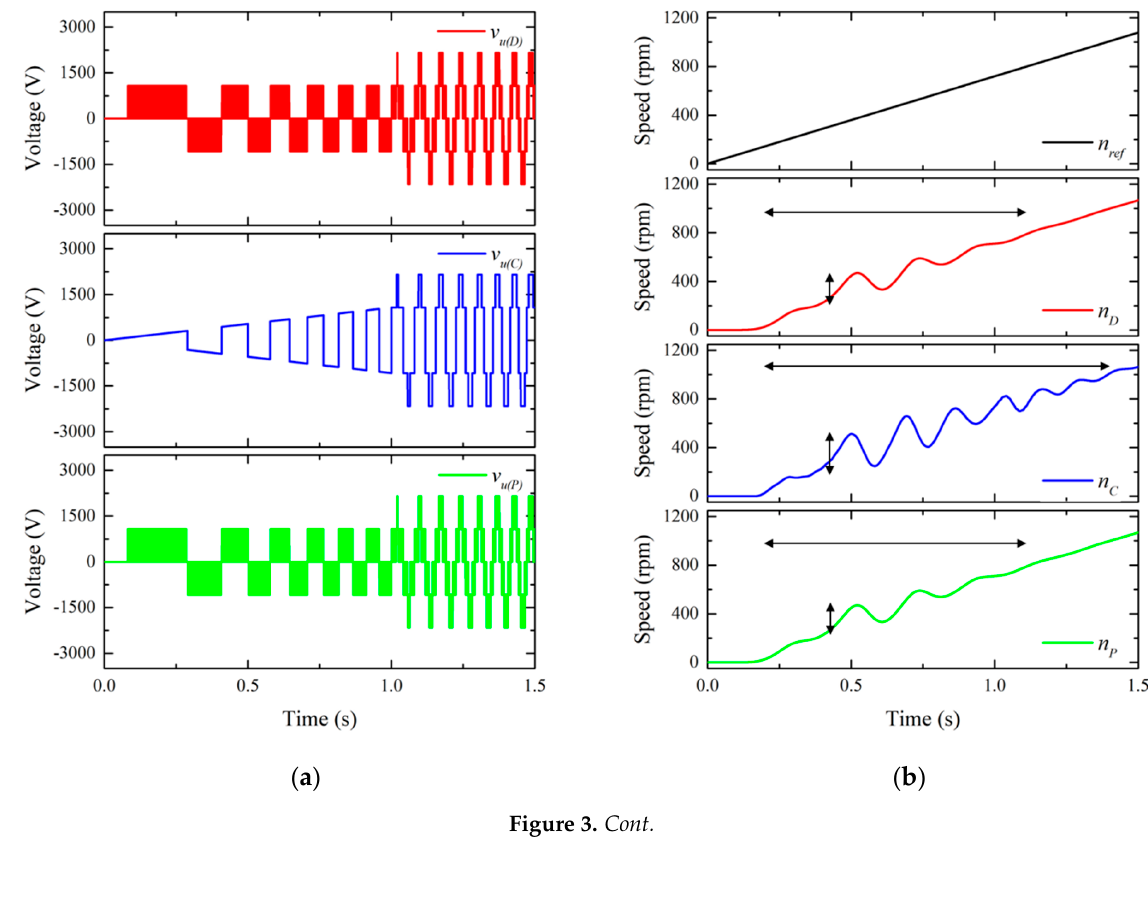
Figure 2. Comparison of switching operation flow charts. ( a ) Conventional model; ( b ) proposed